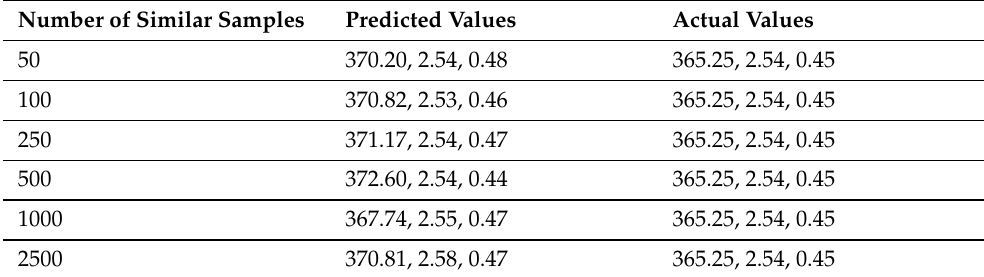
Table 11. Results for experimental unit conversion approach with 2 known traits and 100 experiments depending on the number of similar samples.